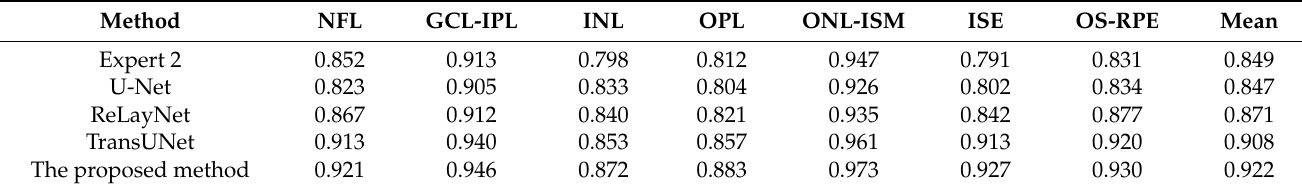
Table 7. Quantitative comparison of Dice coefficients of the stratified results of each method on the POne dataset.